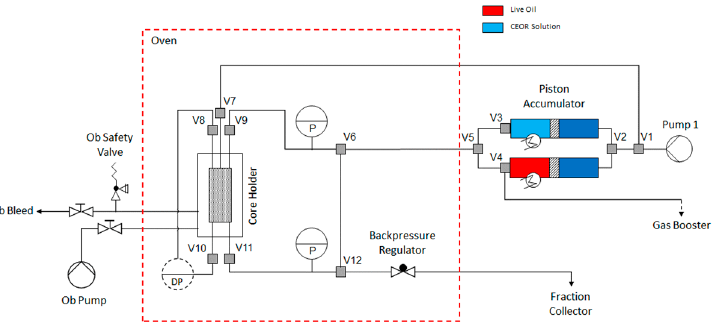
Figure 3. Schematic representation of the experimental setup used for core flooding experiments.